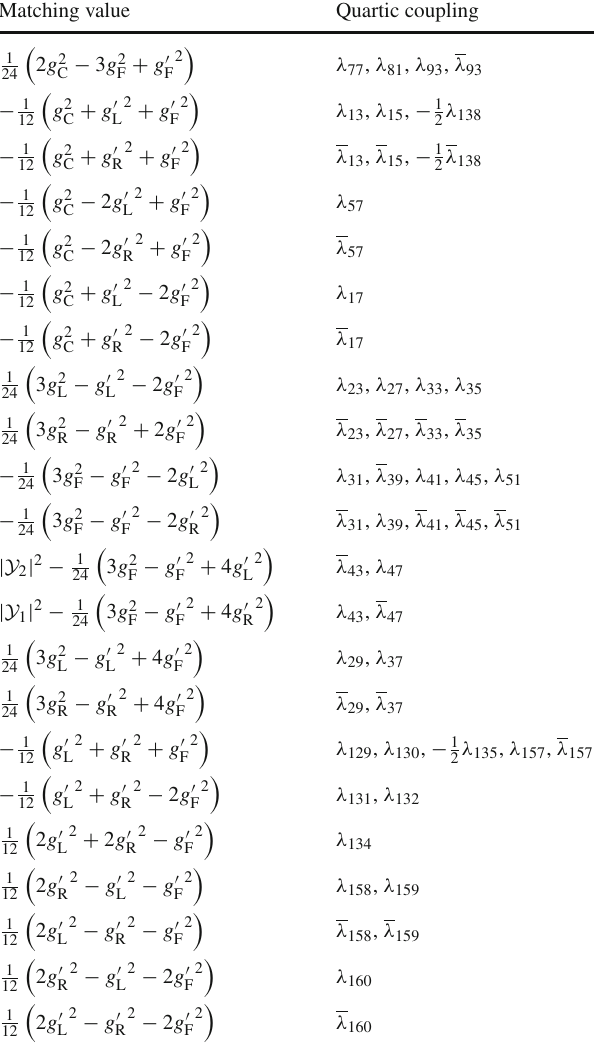
Table 14 Scalar quartic couplings matching conditions with three D- term interactions. The λ i couplings refer to the ( L → R ) part of V 4 Matching value Quartic